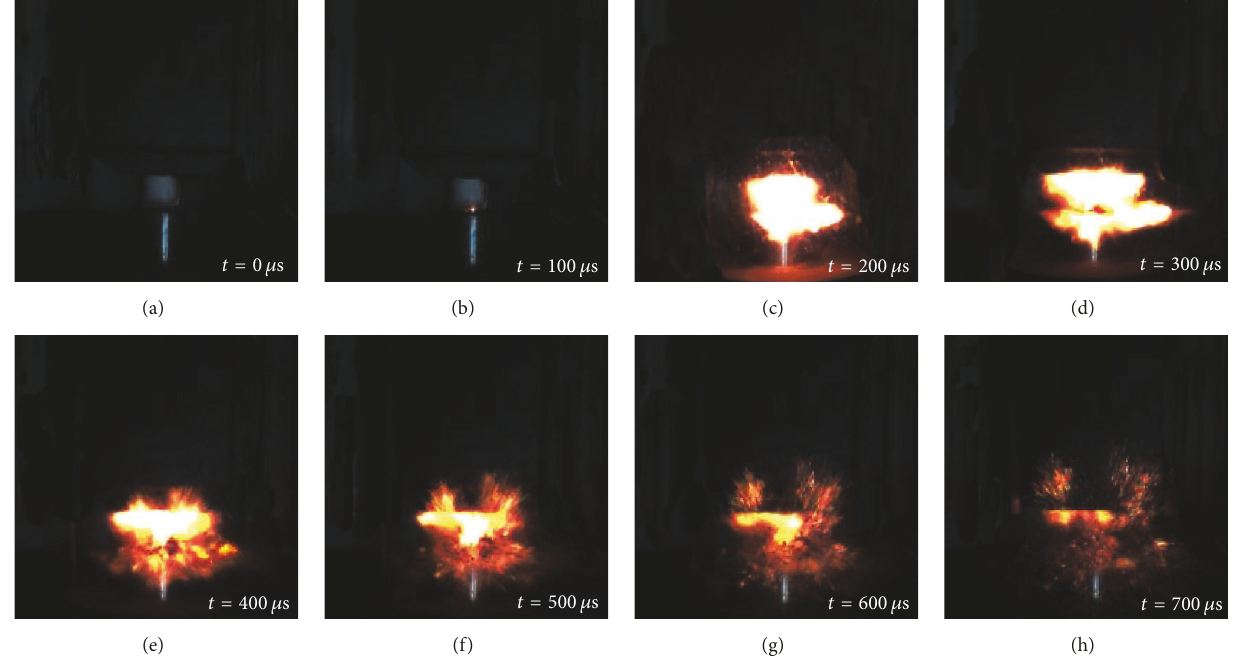
Figure 9: Selected images for a type B specimen reaction recorded by a high-speed camera (from the height of